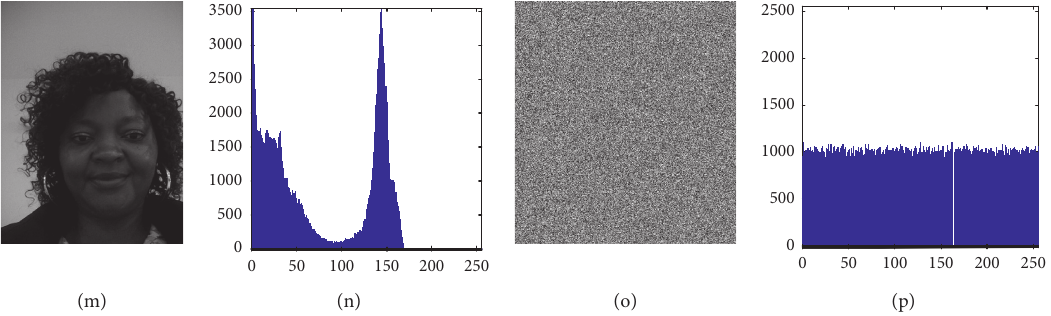
Figure 6: Histogram analysis plain and cipher images using the secret key «A23C56789ABADEF7167DEAB6789367A9»: (a), (b), (c), and (d) A plain image “Balantidium Coli cyst” and its corresponding histogram, cipher image, and cipher image histogram, respectively. (e), (f), (g), and (h) A plain image “echopelv» and its corresponding histogram, cipher image, and cipher image histogram, respectively. (i), (j), (k), and (l) A plain image “Girl (Lena, 4.2.04)» and its corresponding histogram, cipher image, and cipher image histogram, respectively. (m), (n), (o), and (p) A plain image “Guefack» and its corresponding histogram, cipher image, and cipher image histogram, respectively.